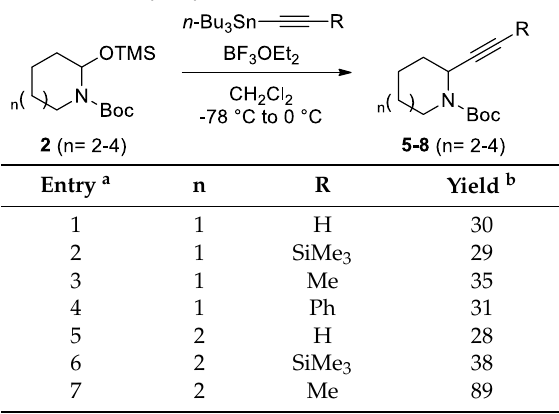
Table 3. Acetylenylation of N , O -acetal TMS